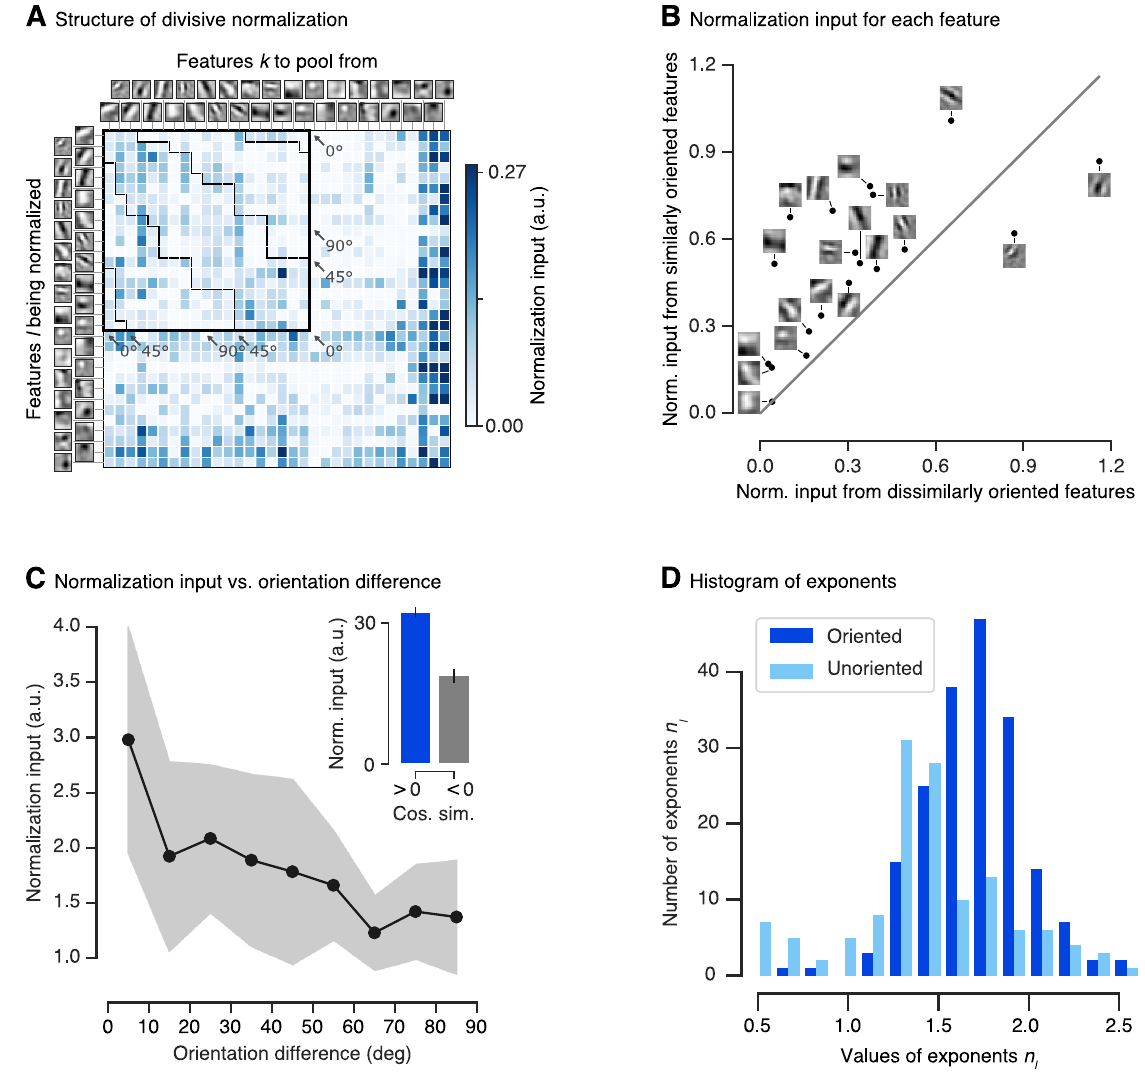
ð x Þi in y n k k kl x